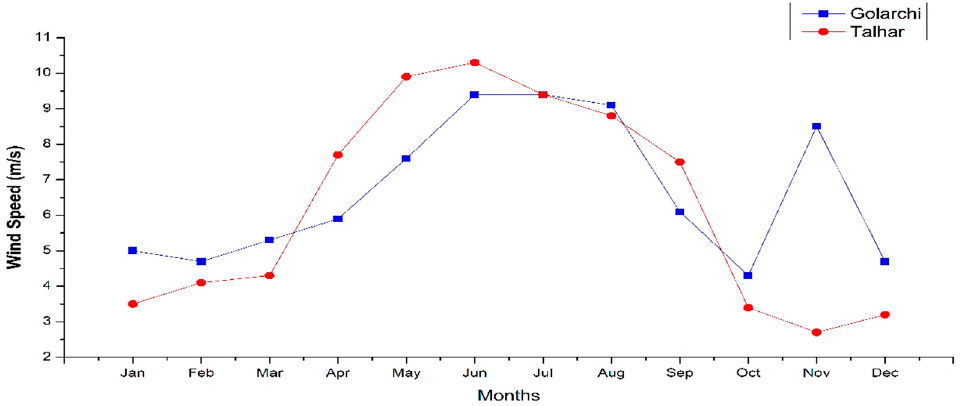
Figure 13 . Annual Wind Speed for Zone 3 (Badin).